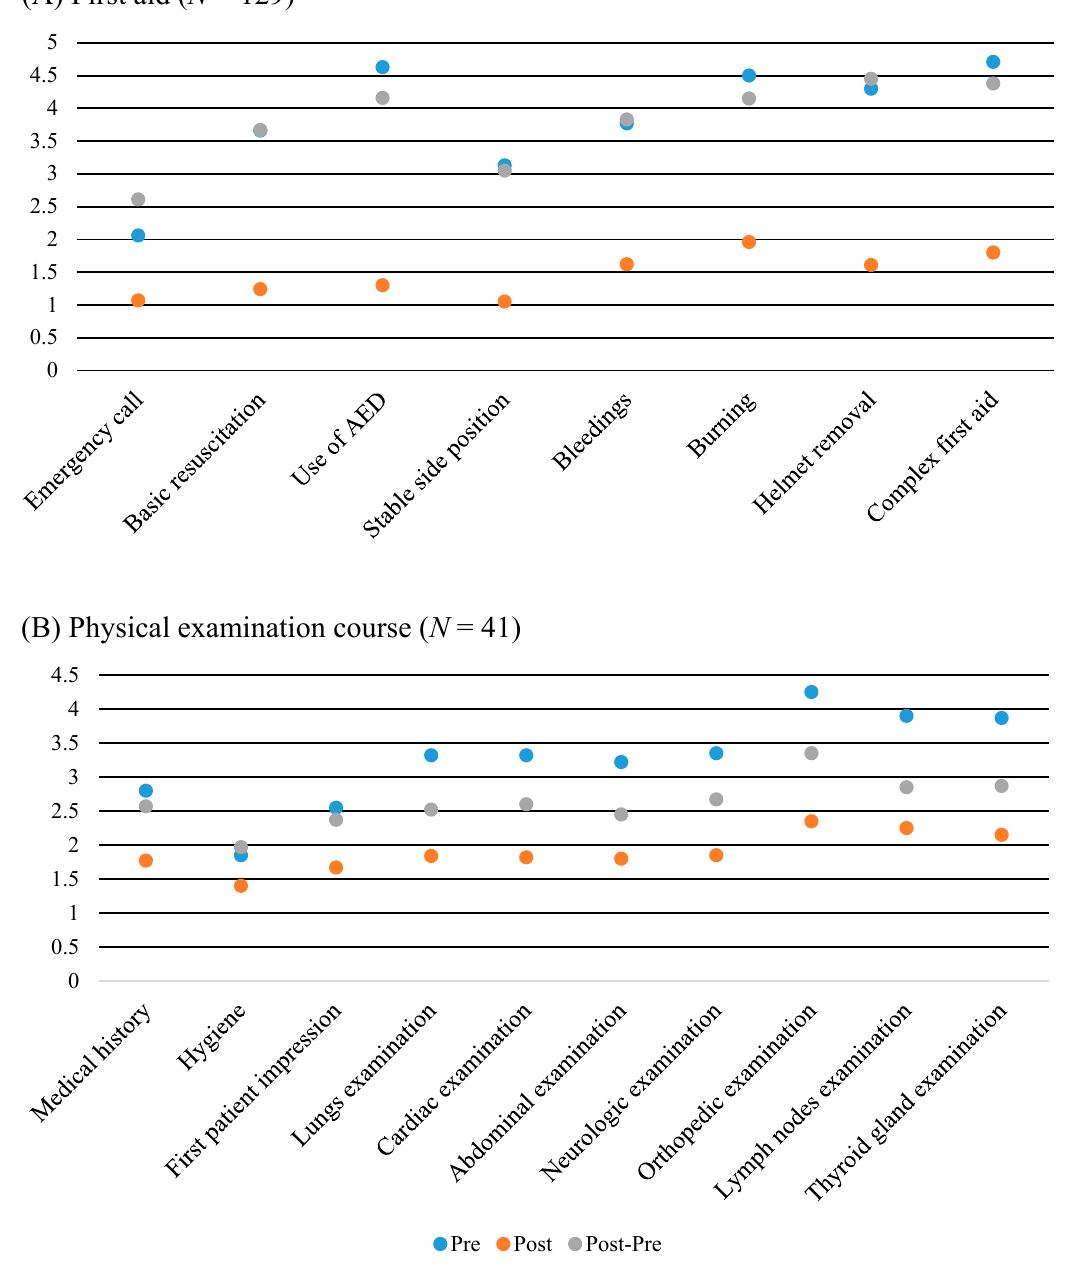
Figure 3. Illustrated comparisons of pre-, post-, and post-pre-evaluations in the first aid ( A ) and physical examination course ( B ).